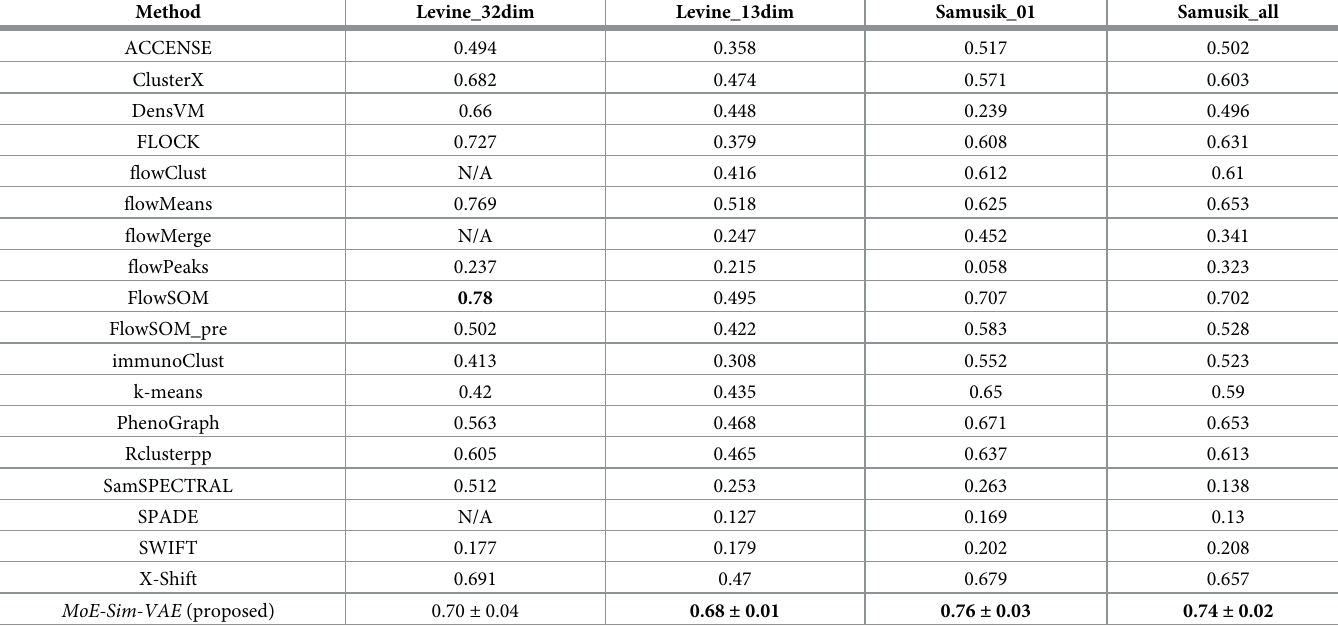
Table 3. Comparison of MoE-Sim-VAE performance to competitor methods in defining cell type composition in CyTOF measurements. The results in the table are extracted from the review paper of [42], where 18 methods are compared on four different datasets. Our model outperforms the baselines on three out of four data sets.